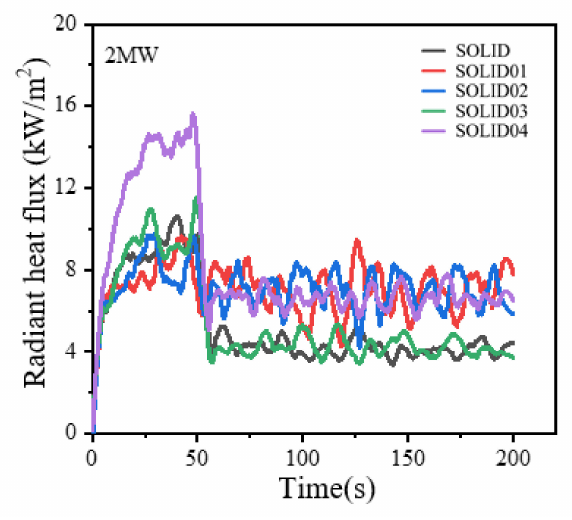
Figure 15. Glass radiant flux variation under window sprinkler